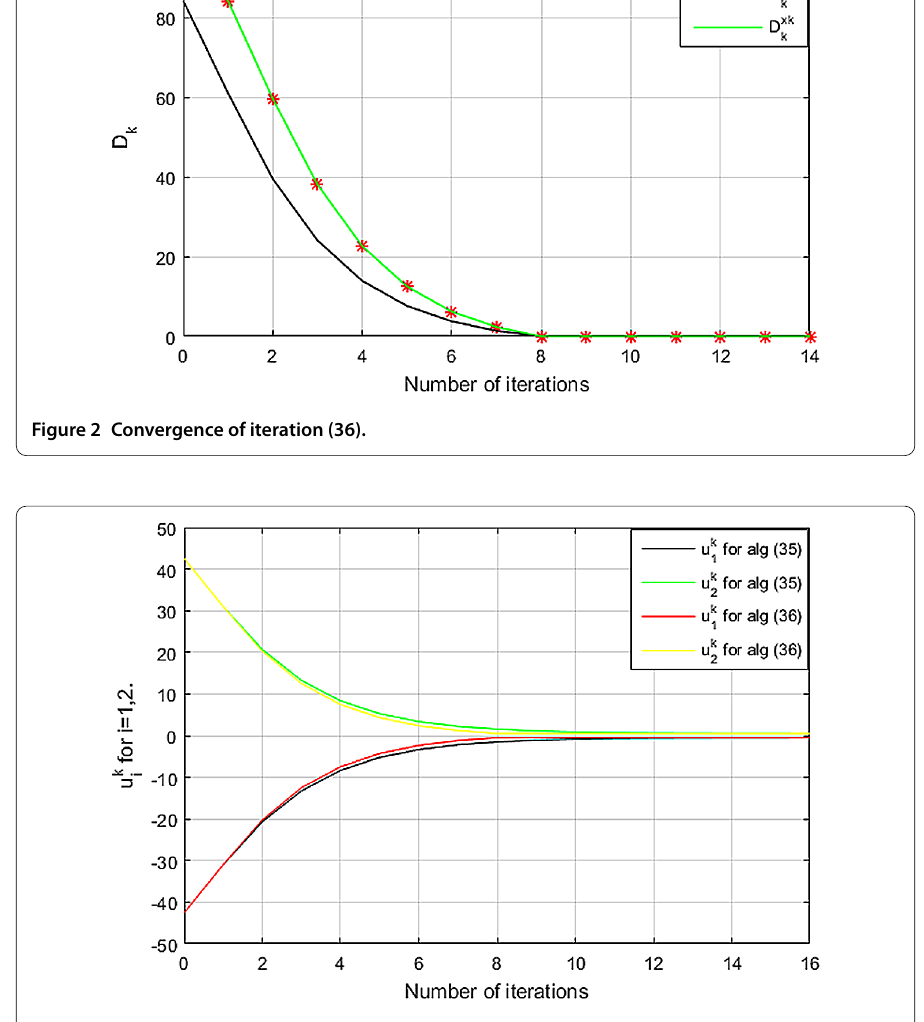
Figure 3 Convergence of { u k } for iteration (35) and iteration